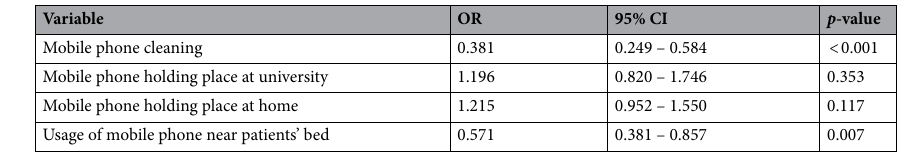
Table 2. Factors independently associated with fungal contamination of students’ mobile phones – results of multivariate logistic regression analysis. OR odds ratio; CI confidence interval.